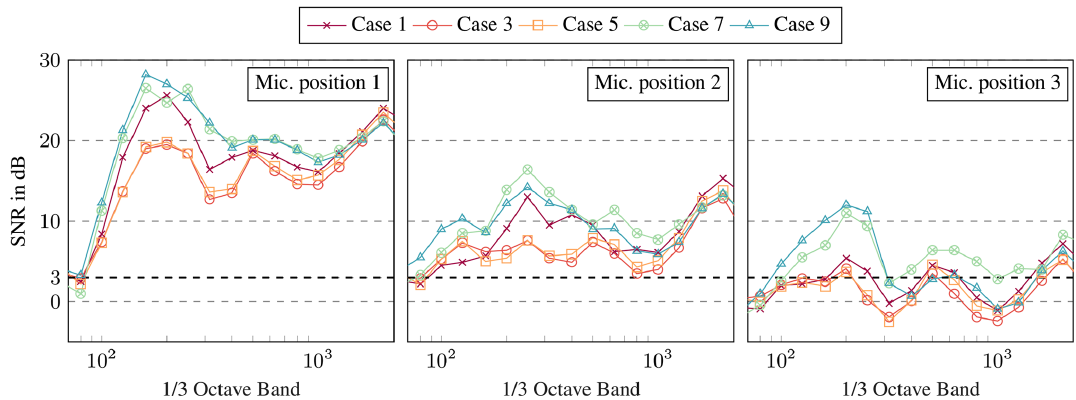
Figure 7. Signal-to-noise ratio per one-third octave band for selected cases at three microphone positions. The background noise at bin 4 is used for the